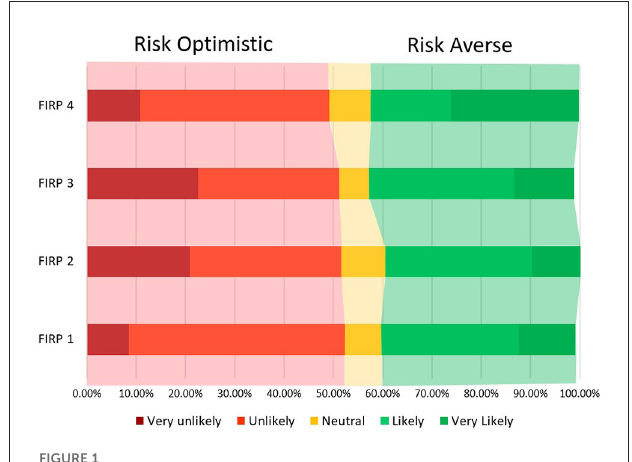
FIGURE1 The level of the four FIRP